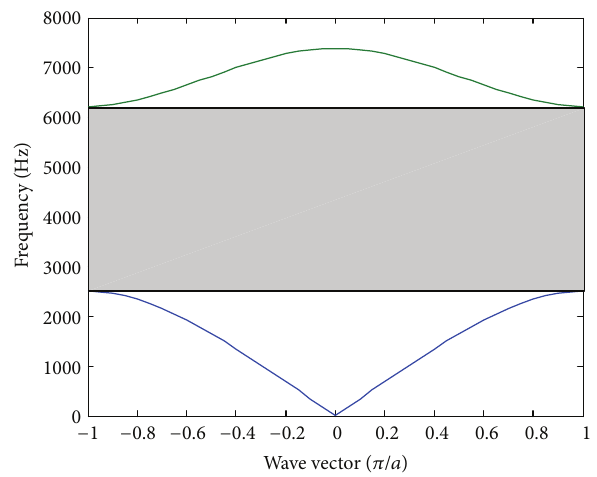
Figure 8: Band structure (aluminum-epoxy beam).